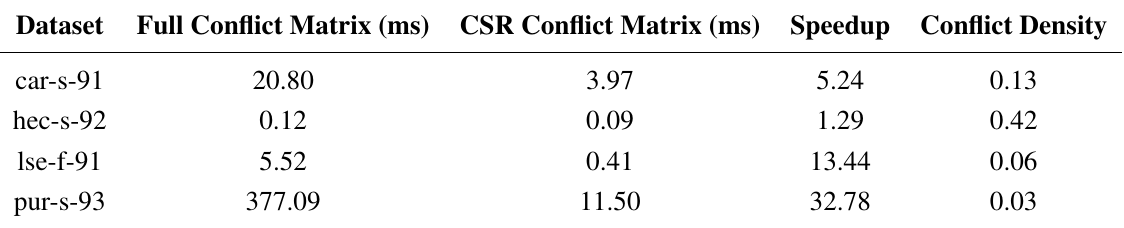
Table 3. GPU evaluation execution time and speedup between the full conflict matrix and the compressed sparse row format